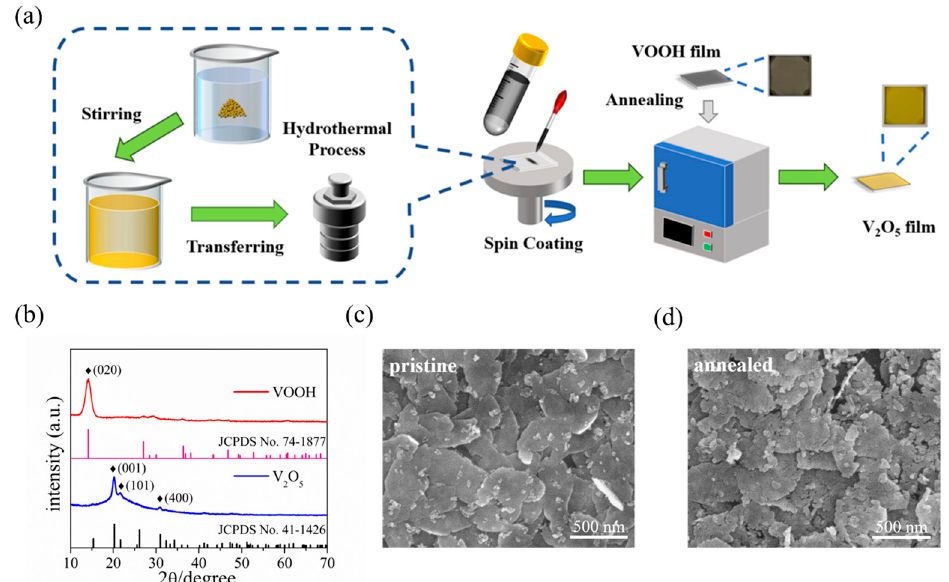
Figure 1. ( a ) Schematic illustration of the synthesis route of V 2 O 5 nanosheets film in this work. ( b ) XRD patterns of VOOH and V 2 O 5 . ( c ) SEM image of the VOOH nanosheets film. ( d ) SEM image of the V 2 O 5 nanosheets film.